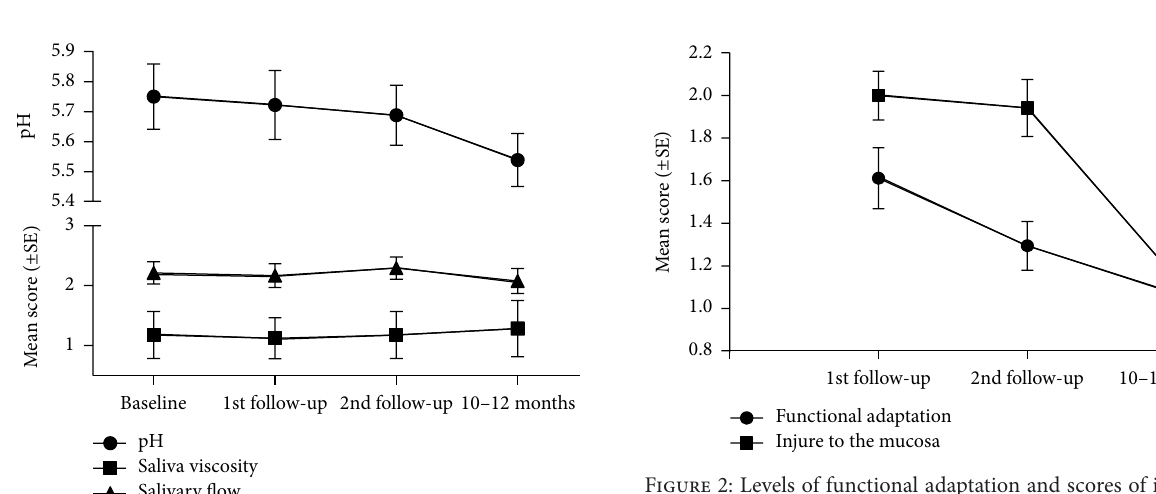
Figure 2: Levels of functional adaptation and scores of injuries to the mucosa assessed in the follow-up appointments ( 𝑛 = 19). Values are presented as mean and standard error ( ∗ 𝑝 < 0.05; Wilcoxon matched-pairs signed rank